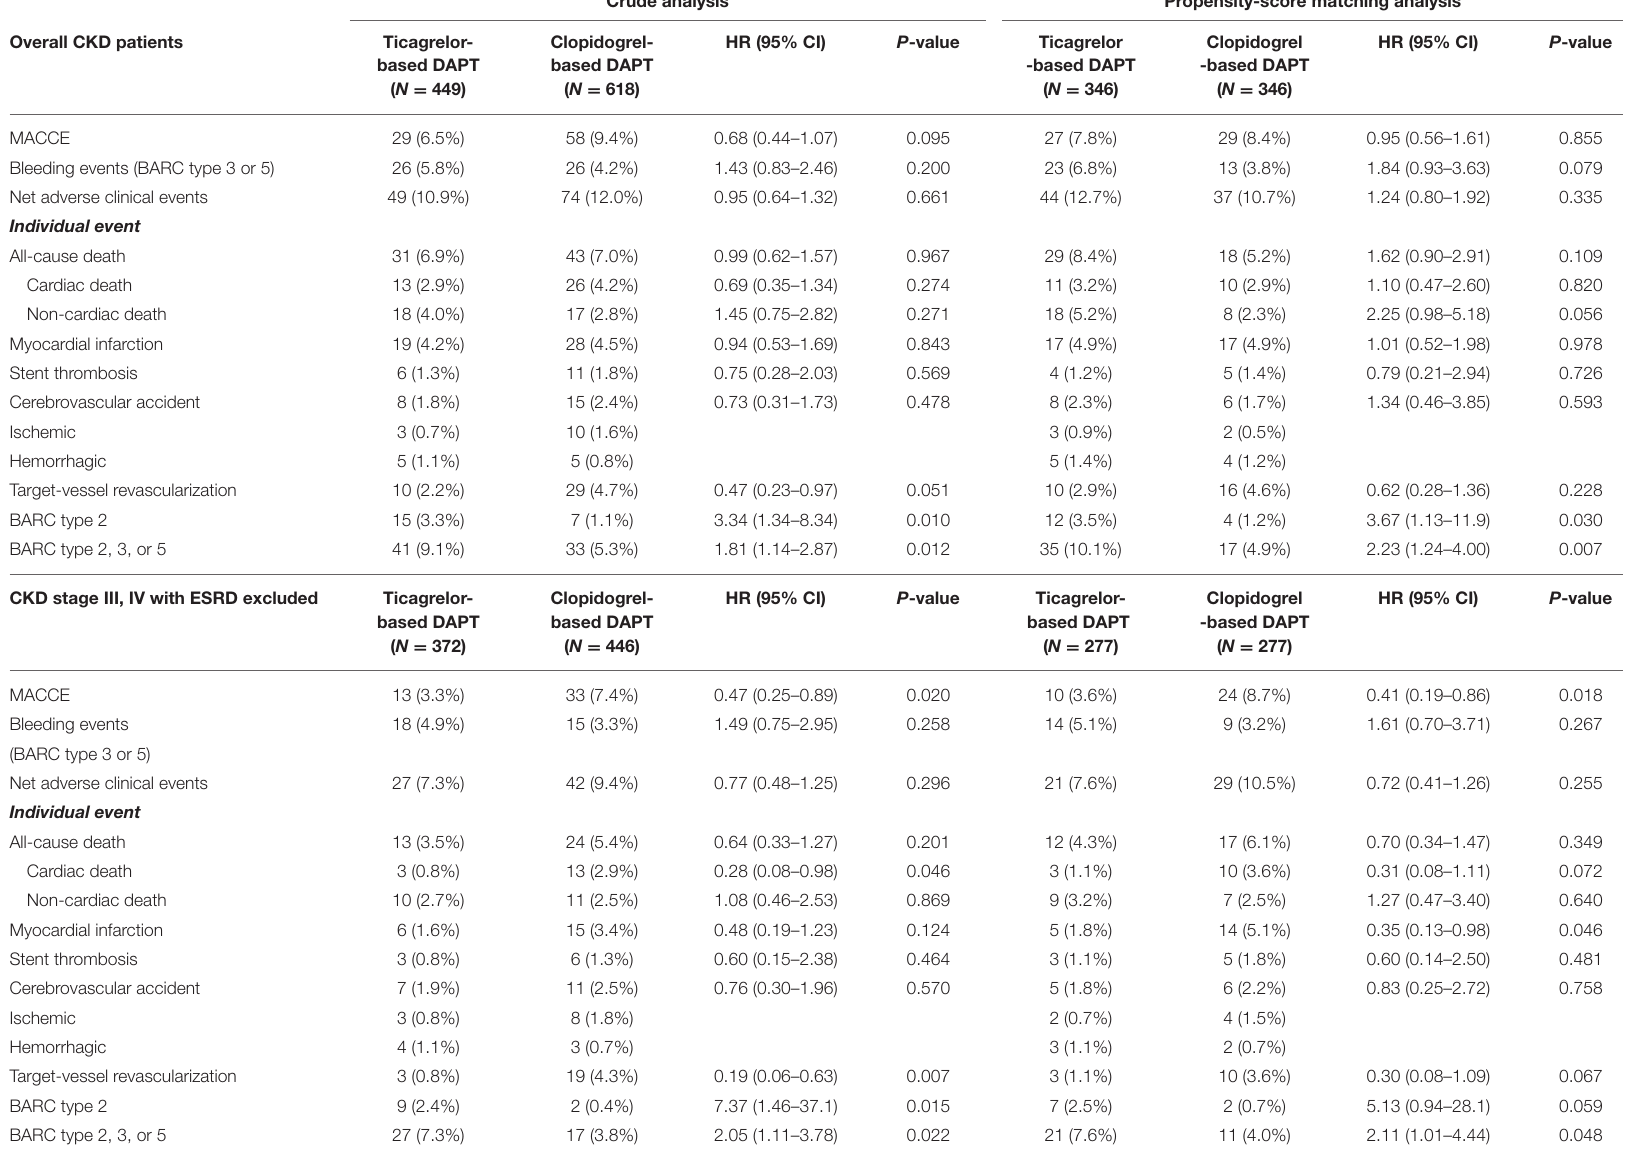
Crude analysis Propensity-score matching